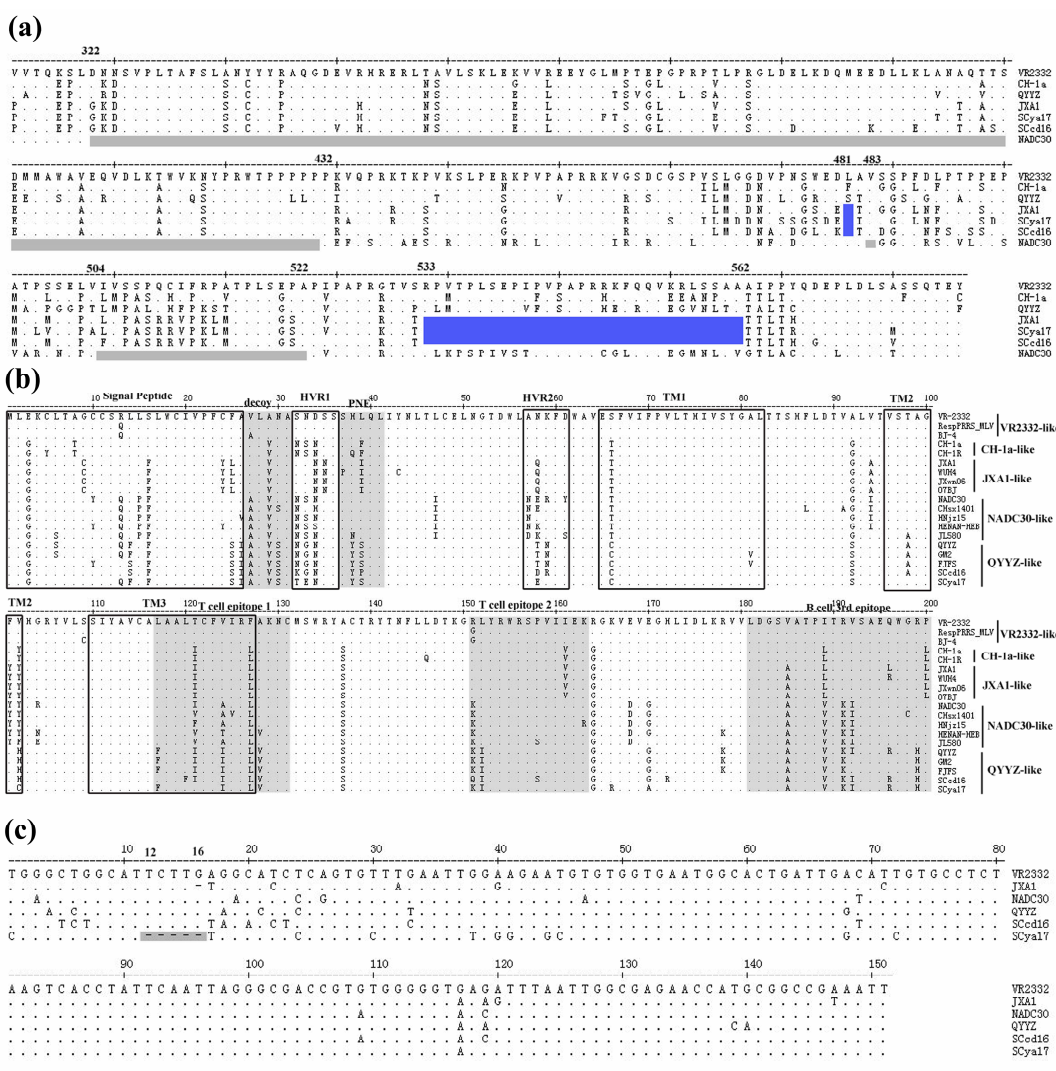
Figure 3. The sequence alignment of Nsp2, GP5, and 3′-UTR. ( a ) Two discontinuous amino acid deletions (481 and 533–562) in Nsp2 of SCcd16 and SCya17 (blue regions). Three discontinuous amino acid deletions (322–432, 483, and 504–522) in Nsp2 of NADC30 (gray regions); ( b ) multiple alignment of GP5 amino acid sequences of SCcd16 and SCya17 and seventeen PRRSV reference strains. Black boxes indicate the regions of signal peptide, two hypervariable regions (HVRs), and three transmembrane domains (TMs). Gray areas indicate the amino acid residues in the decoy epitope, primary neutralizing epitope (PNE), two T cell epitopes and the 3rd B cell epitope; ( c ) five continuous nucleotides deletion in 3′-UTR at positions 12 to 16 of SCya17 (gray region).